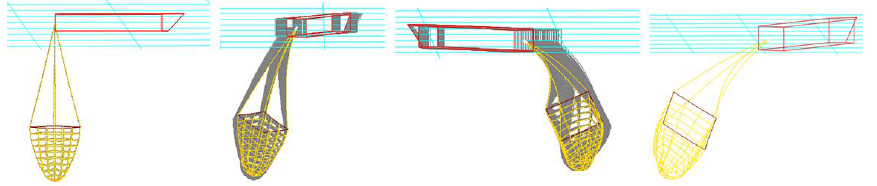
Figure 24. Shape changes of rigid truss trawl rotating towing under fixed turning radius at v = 5 m/s.